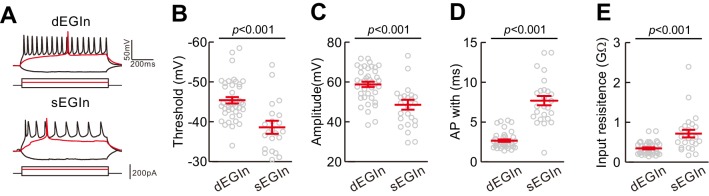
Electrophysiological properties of sEGIns (layer 2/3) and dEGIns (layer 5/6) at P5–7.(A) Representative traces showing voltage responses of dEGIns (top) and sEGIns (bottom) to step current injections. Red traces indicate the first evoked action potential. (B–E) Comparison of AP threshold (B), AP amplitude (C), AP width (D) and input resistance (E) between dEGIns and sEGIns. Detailed statistical analysis, detailed data and exact sample numbers are presented in the Figure 2—source data 1. Error bars indicate mean ± SEM.